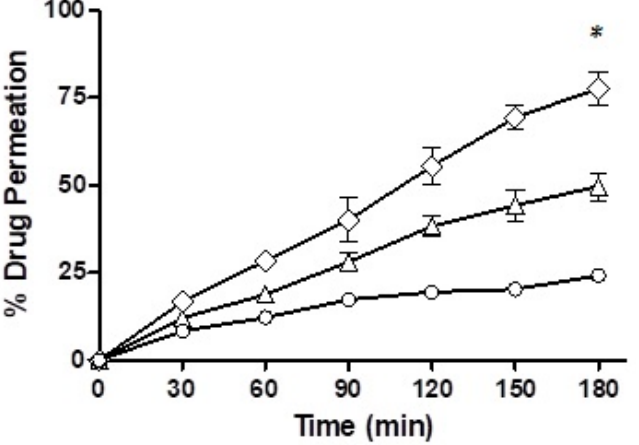
Figure 10. Percentage of ACV permeated through a layer of rabbit intestinal mucus via free drug solution ( ◯ ), loaded into F7 ( △ ) and F10 ( ◇ ) studied over a period of 3 h. * indicates that the outcomes of F10 are significantly different than F7.